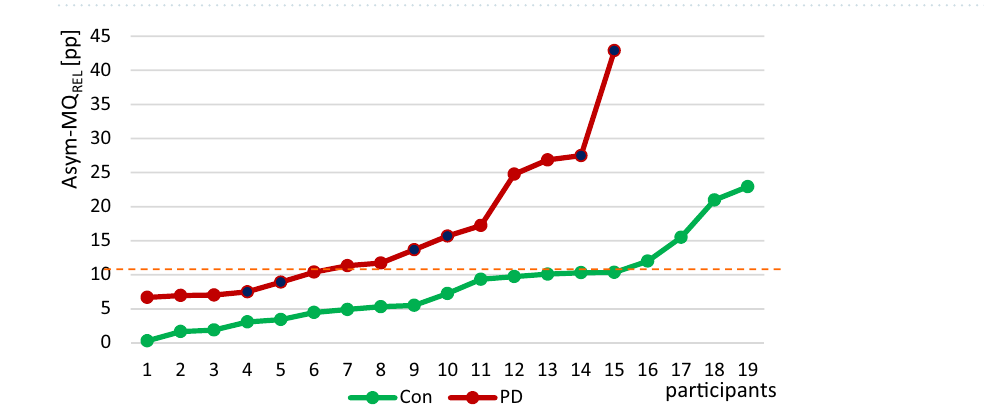
Figure 6. Relative interlimb asymmetry of MQ rel . Displayed are the relative differences between left and right MMG of biceps brachii muscle according to the parameter MQ REL between the PD patients and the controls sorted by size. The dotted line shows a possible boarder according to the 95%-CI at approximately 11 pp difference. The dark filled circles represent the PD patients with a side difference in UPDRS of > 2